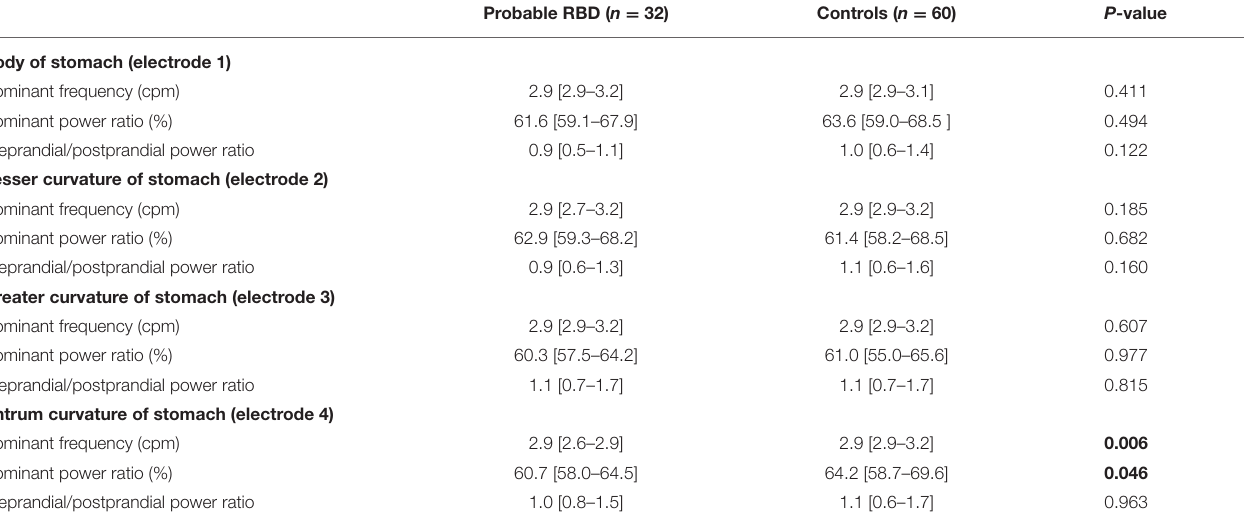
TABLE 2 | The electrogastrogram parameters of controls and participants with probable RBD *